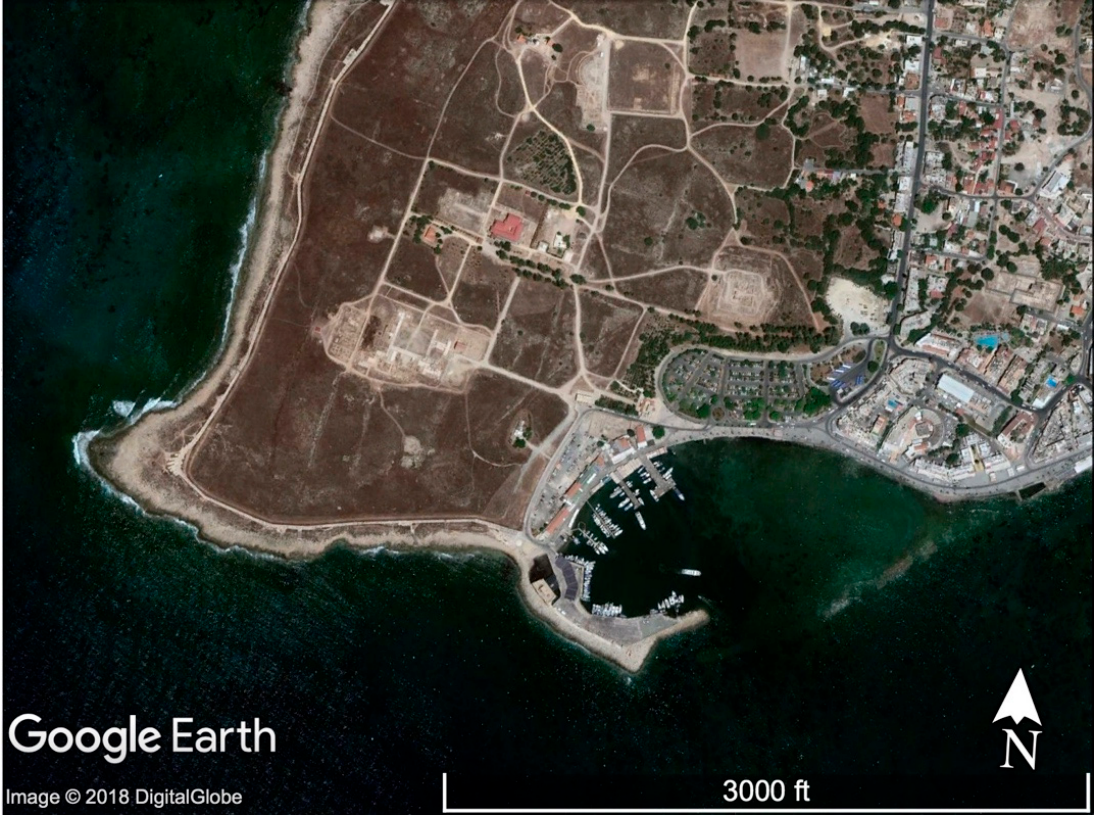
Figure 9. Aerial view of the modern Nea Paphos archaeological site. The remains of the southern port’s breakwater are visible at the bottom right. Source: Google Earth; Map Data: Google, Digital Globe.